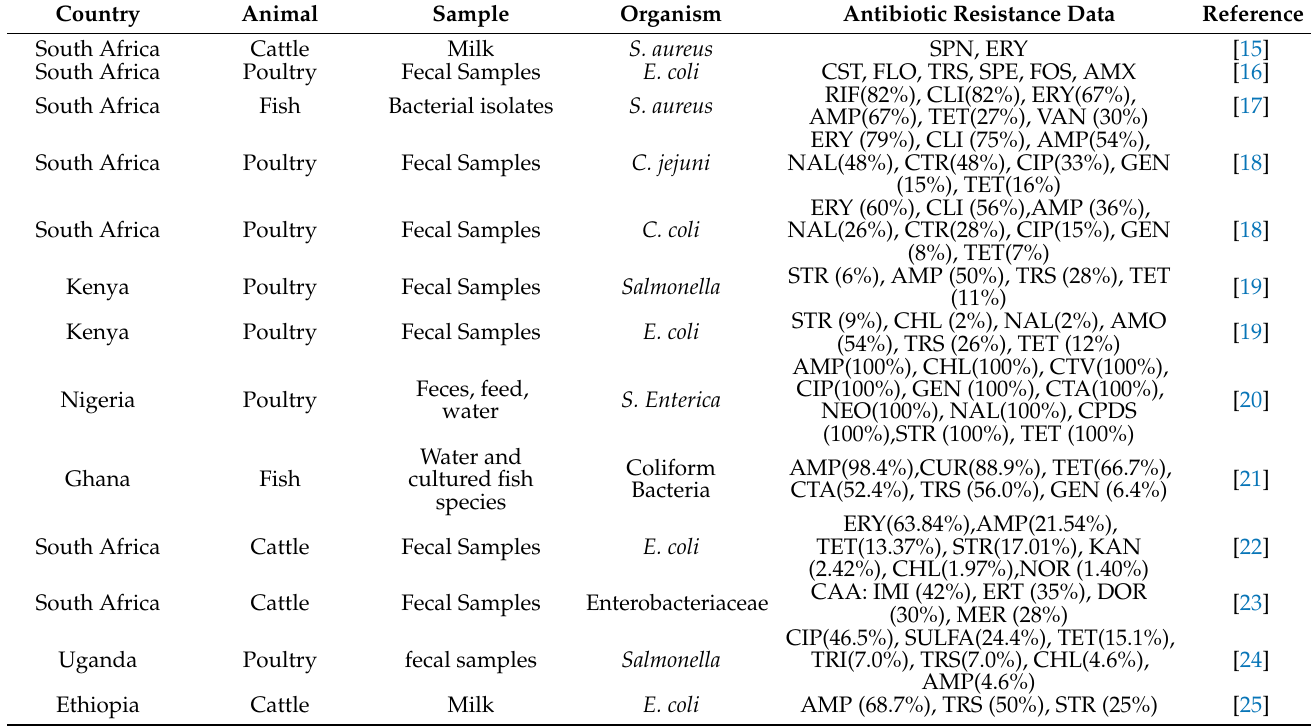
Table 1. Description of antibiotic resistance in different types of bacteria isolated from livestock in